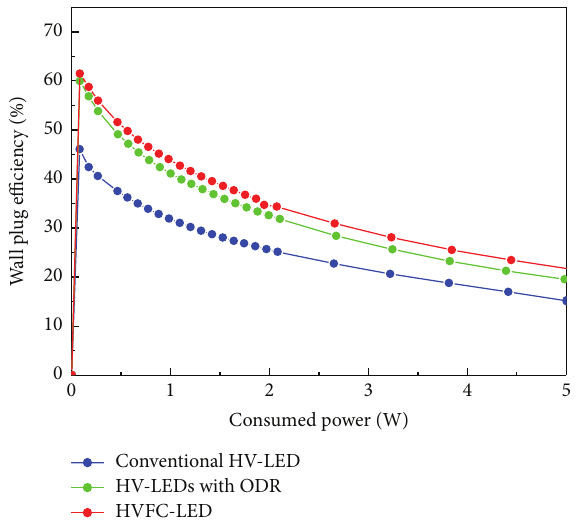
Figure 4: The wall plug efficiency curves of these three LEDs at the same consumed power.